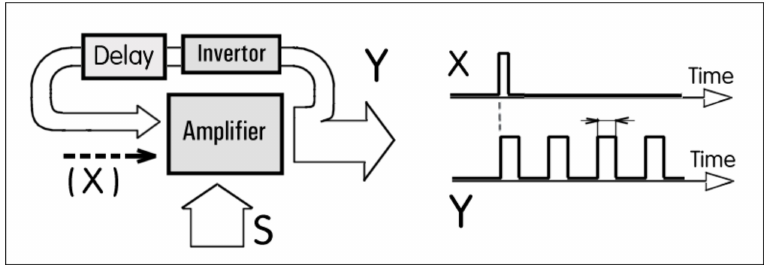
Figure 11. Use of the negative feedback: generation of the periodic pulse train.